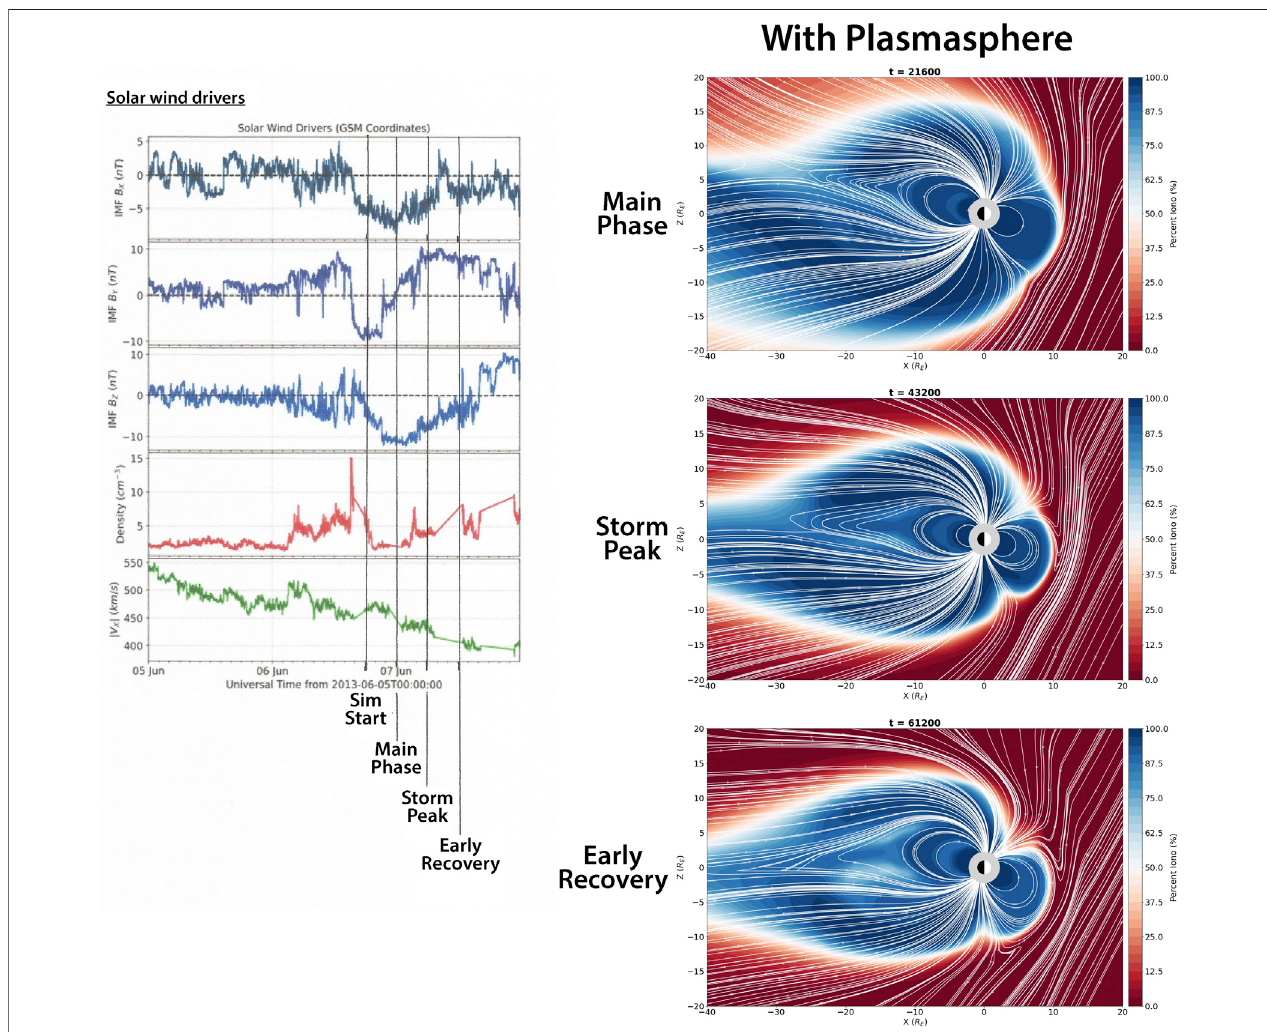
FIGURE13| Modelresultsonthestormperiod shown in Figure12 combiningtheH + and O + contributionsofthepolarwindandpolarcusp(blue)versusthesolar wind H + (red).